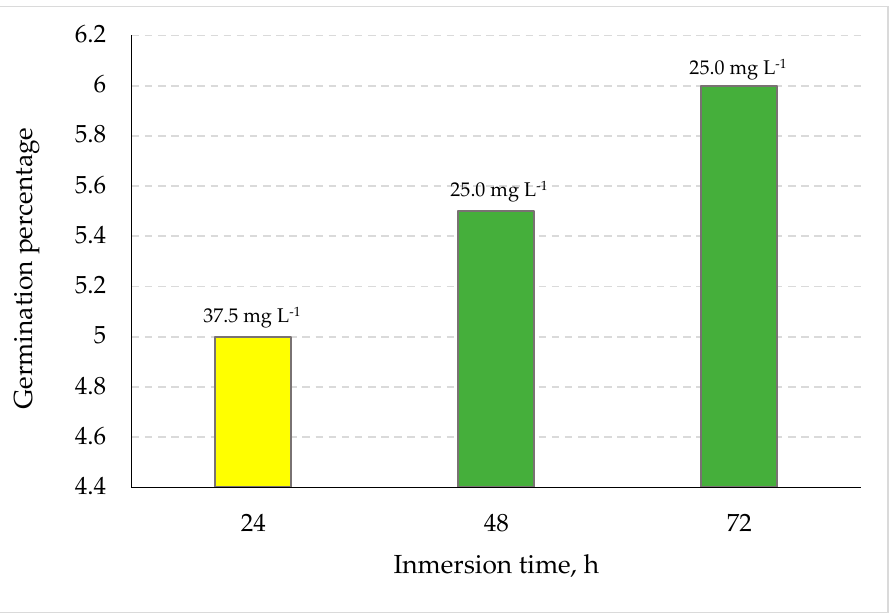
Figure 9. Summary of responses of the germination percentage to Biozyme ® TS (gibberellins) for 24, 48, and 72 h of immersion displaying the best dose for each time.